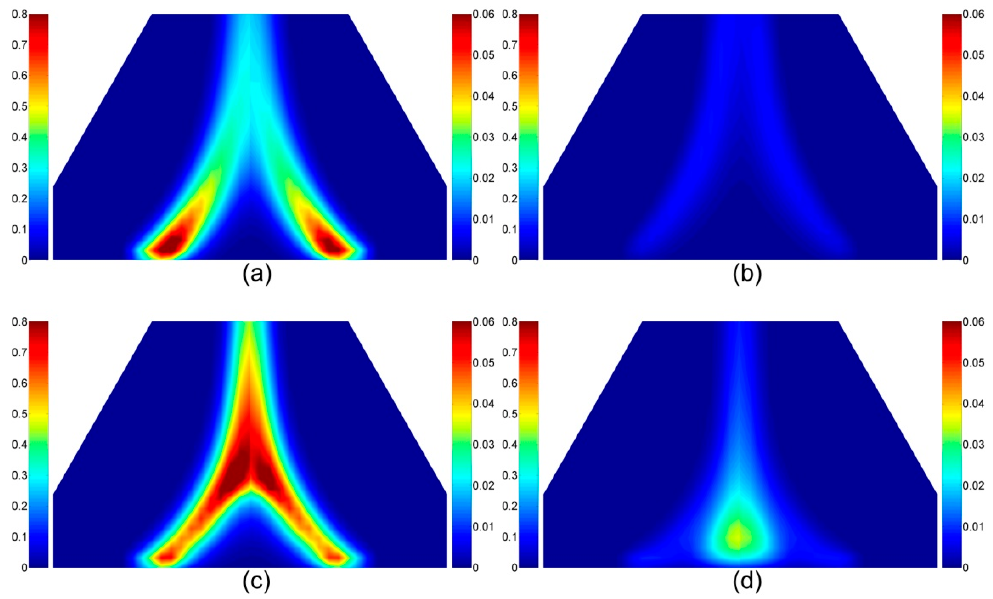
Figure 11. The mass fractions of CO 2 (left half) and CO (right half) in the gas phase for 10 mm thick PC plaque under 75 kW/m 2 heat flux at: ( a ) 100 s; ( b ) 400 s; ( c ) 800 s; and ( d ) 1100 s.